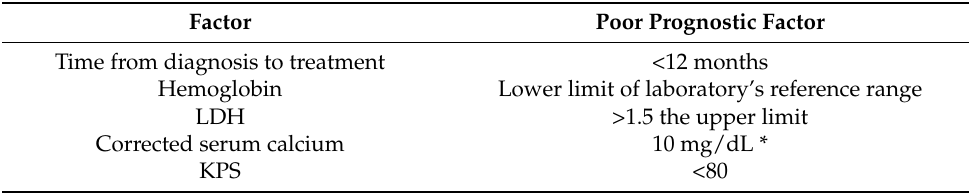
Table 1. Memorial Sloan–Kettering Cancer Center (MSKCC) renal cancer prognostic classification.